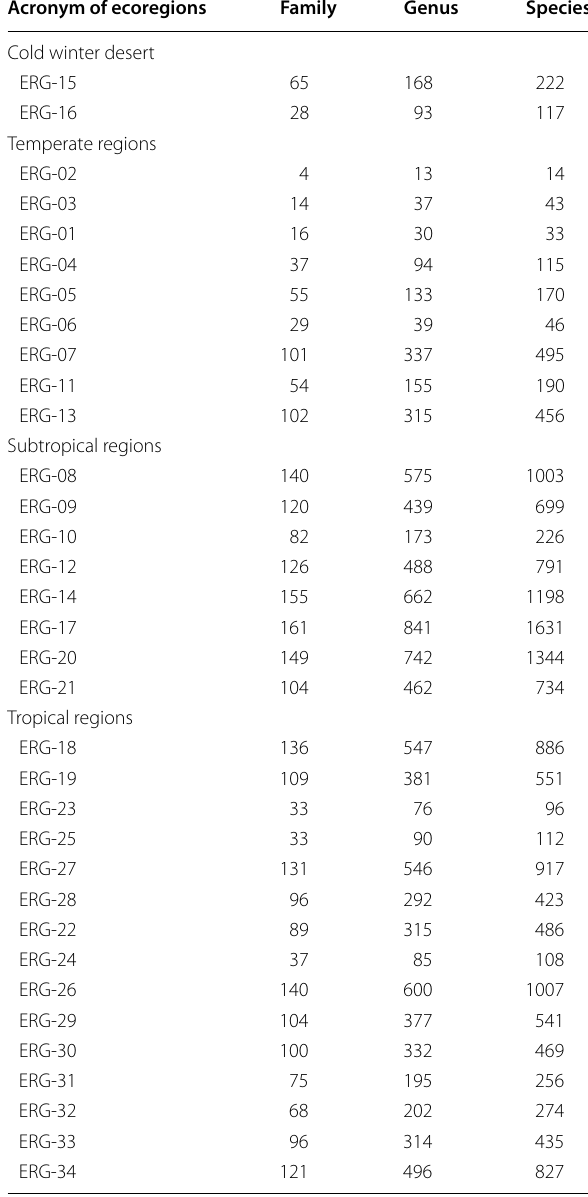
The numbers after ERG and dash are the numbers of ecoregions listed in Table 1 and Fig.